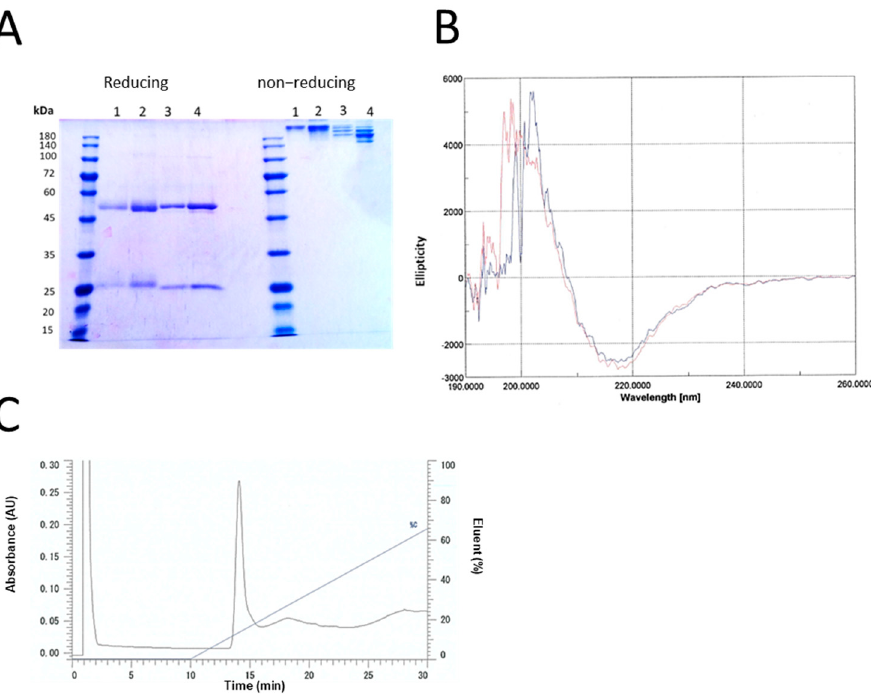
Figure 4. Physicochemical characterization of anti-CR-1 antibody Clone 35. ( A ) purified anti-CR-1 antibody to CR-1 was analyzed by SDS-PAGE under reducing and non-reducing conditions. Lanes